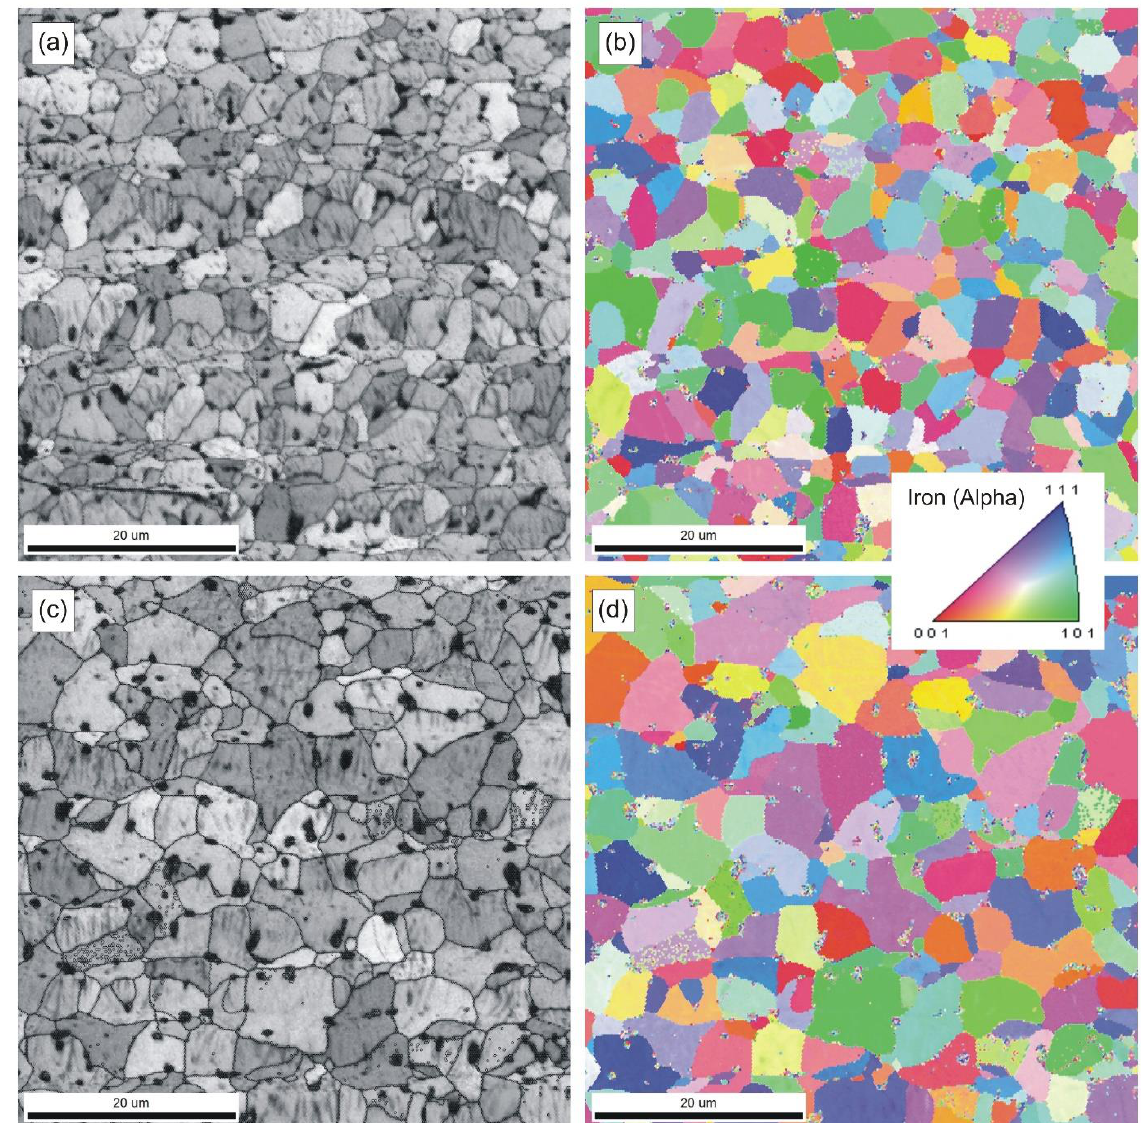
Figure 7. SEM EBSD micrographs ( a , c ) and inverse pole figure (IPF) maps ( b , d ) of samples sintered at: 898 °C ( a , b ) and 924 °C ( c , d ).